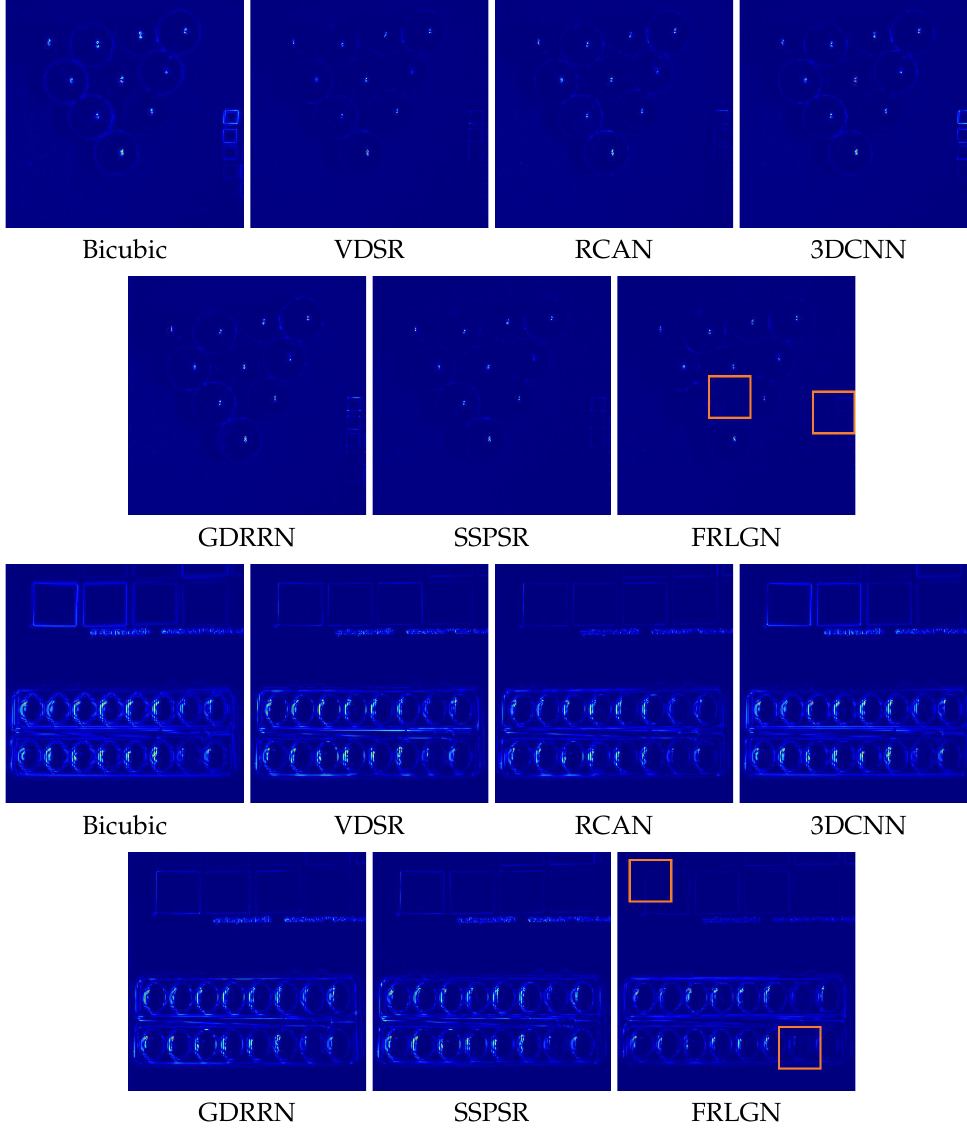
Figure 4. Mean error maps of superballs and paints hyperspectral images from the CAVE testing dataset with a scale factor of 4